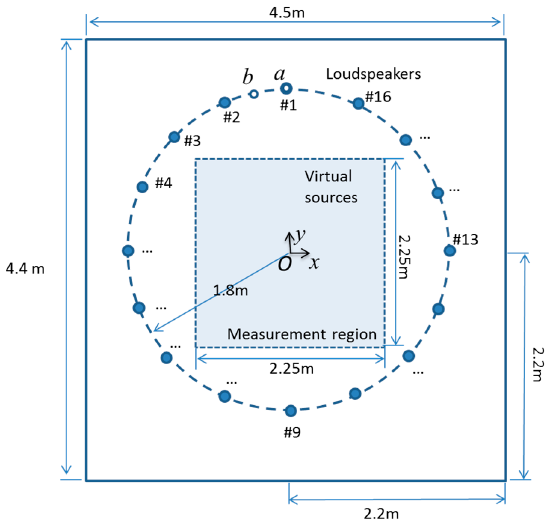
Figure 7. The listening room, loudspeaker array, and virtual sources.